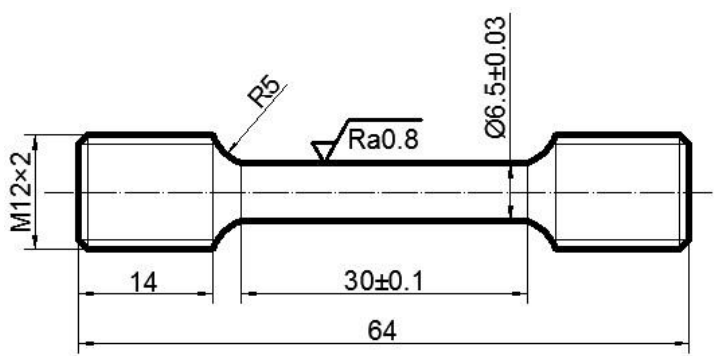
Figure 2. Shape of the high temperature tensile specimen (unit: mm). The test is conducted using an Instron 3369 high-temperature testing machine. The temperature control accuracy of the testing machine is ± 1 ◦ C, the force control accuracy is ± 0.1 MPa, and the displacement control accuracy is ± 1 µ m. At the beginning of the experiment, the sample was heated to the specified temperature (820 ◦ C, 870 ◦ C, and 920 ◦ C) at an initial heating rate of 20 ◦ C/min. The temperature was increased slowly to the given temperature when the temperature is close to the given value due to the PID control strategy of the equipment. The entire heating time is about 1 h. Then, the samples were cooled down to 20 ◦ C in the heating furnace after the tests. This temperature was maintained for 5 min to guarantee the generation of a uniform temperature. Following this, the sample was stretched at a constant stretching speed (0.01, 0.1, or 0.28 s − 1 ). Subsequently, the sample was cooled to room temperature at a cooling rate of 50 ◦ C/min. During the experiment, the temperature, force, and strain were collected simultaneously. Due to the measuring range limitation of the strain extensometer, the strains were collected using the external extensometer first. When the strain reached the maximum measuring range of the external physical extensometer, the extensometer was removed, and the strains were collected using in-built extensometers of the Instron machine. In order to gain accurate stress–strain curves, the tests were repeated two times at each deformation condition, and the average values were shown in the true stress strain curves